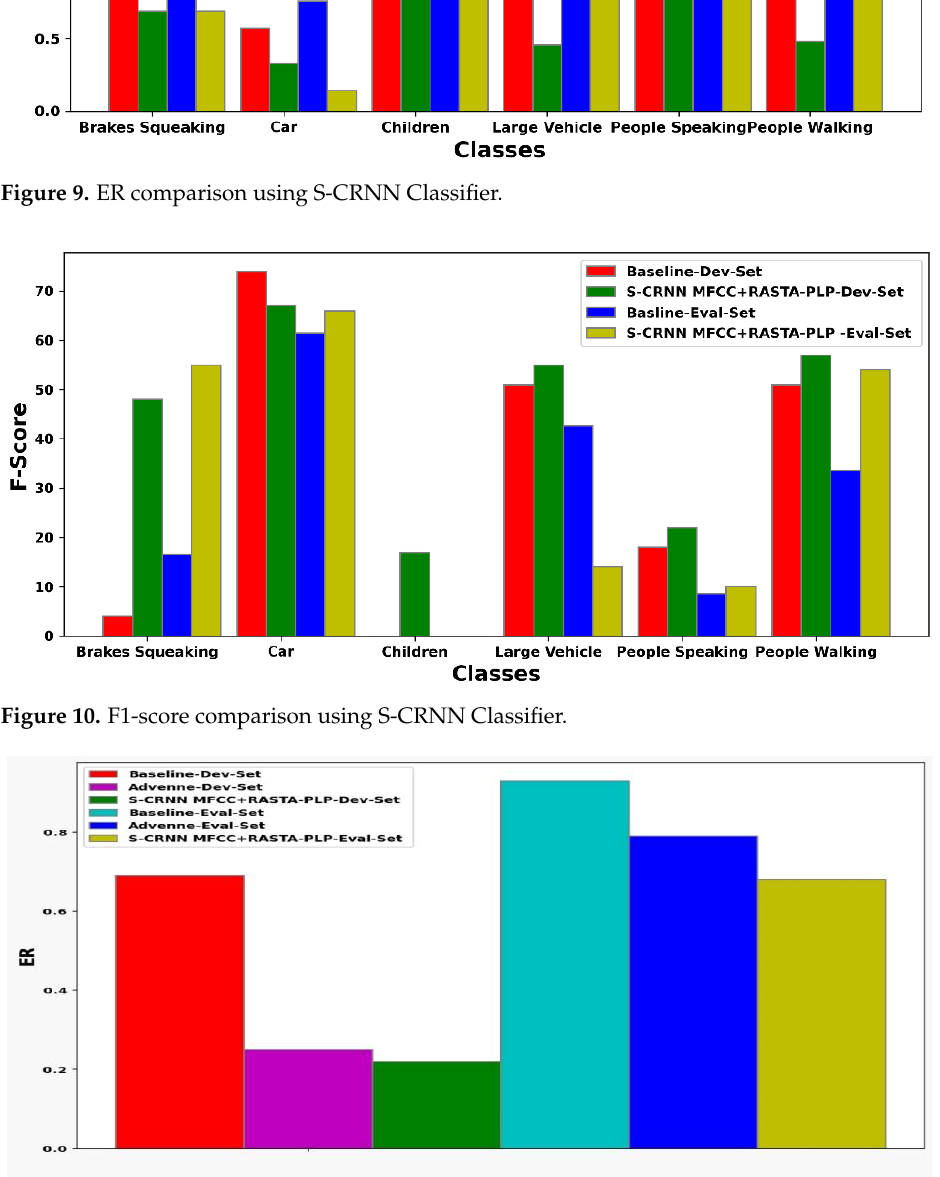
Figure 12. Overall F1-score comparison using S-CRNN Classifier . We evaluated the performance of our proposed S-CRNN model and compared the overall ER and F1-score with the baseline model, as shown in Figures 11 and 12. The base- line model obtains an overall ER of 0.69 and an overall F1-score of 56.7% on the Dev-Set, whereas these scores are 42.8% and 0.93, respectively, on the Eval-Set. On the Dev-Set, the Adavanne model achieves an overall ER of 0.25 and an overall F1-score of 79.3%, whereas on the Eval-Set it achieves an overall ER of 0.79 and an overall F1-score of 41.7%. On the Dev-Set, our proposed S-CRNN model obtains an overall ER of 0.22 and an overall F1- score of 72%, whereas on the Eval- Set the overall ER is 0.68 and the F1-score is 51%. These results clearly demonstrate that the S-CRNN model increased the overall F1-score by over 10% and the ER by 0.11 on the Eval-dataset. Additionally, our proposed S-CRNN per- formed well on the Dev-Set, with an improved overall ER of 0.3, showing the efficacy of our proposed model. 6. Conclusions In this article, we have introduced a novel multi-model for the SED challenge in ur- ban environments. Because there are several sound event categories which need to be de- tected and identified in the urban SED task, our main focus in this article was to divide the dataset into two subclasses of audio events prevalent in urban environments. For this, all the machine-generated (i.e., artificial) sound events were placed in the first subclass, while natural sounds such as human conversation were categorized in the second sub- class. To achieve this, we employed two distinct features (MFCC and RASTA-PLP spectra) for the two subclasses rather than a single feature for both subclasses. We ran multiple